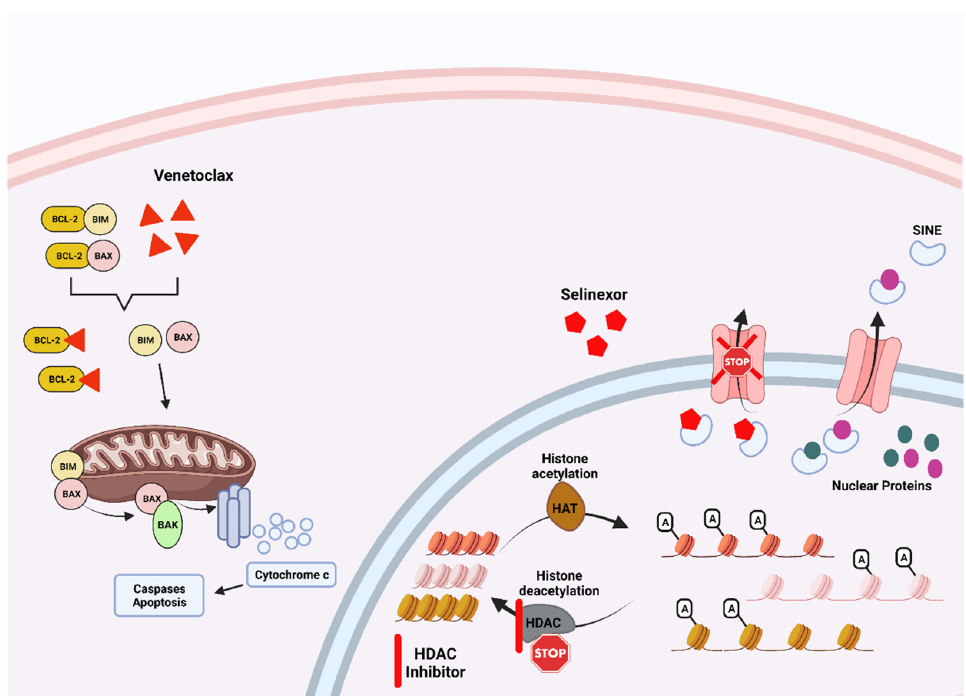
Figure 4. Underlying mechanism of action of selected targeted therapies used for MM in the clin- ical setting. Venetoclax works by primarily binding to the BCL-2 anti-apoptotic protein, allowing the activation of BAK and subsequently caspases leading to MM apoptosis. Selinexor blocks the transport of vital proteins and other molecules from the nucleus to the cytoplasm of the MM cells, leading to cell death. Histone deacetylation inhibitors act at an epigenetic level, blocking the deacetylation of the DNA in the nucleus of the malignant cell.